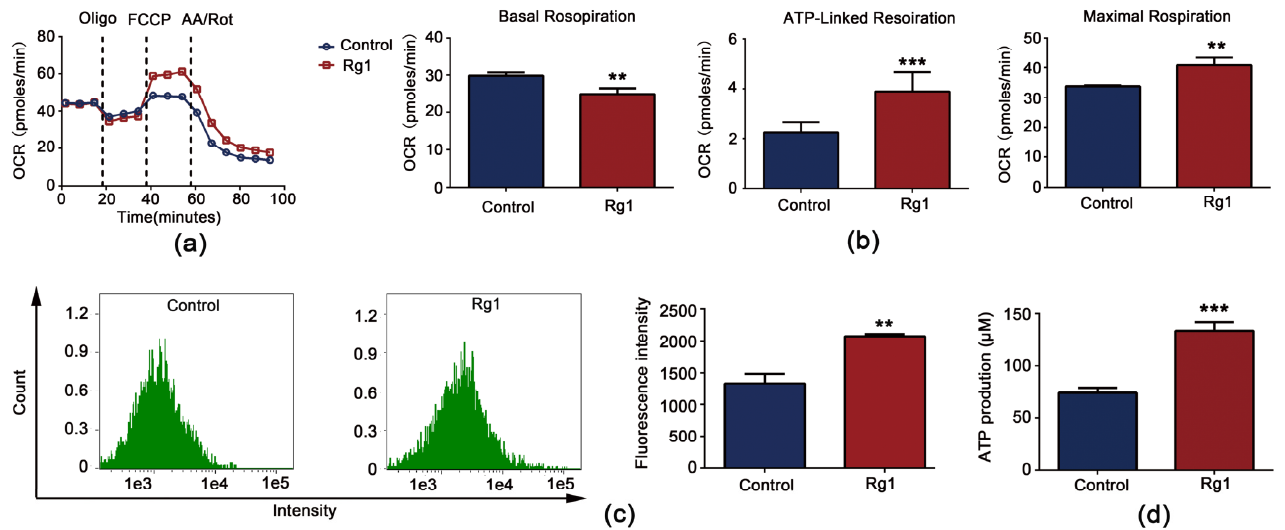
Figure 8. Effects of Rg1 treatment on mitochondrial respiration. ( a ) Graphical representation of oxygen consumption rate (OCR) measurements over time. ( b ) Calculation of representative functional parameters of OXPHOS from OCR curves. “Basal Respiration” indicates the OCR in the absence of oligomycin; “ATP-linked Respiration” indicates the OCR after injection of oligomycin; “Maximal Respiration” indicates the OCR after injection of FCCP. ( c ) Mitochondrial membrane potential (MMP). (d) ATP production. Compared with untreated controls, ** p < 0.01, *** p < 0.001.